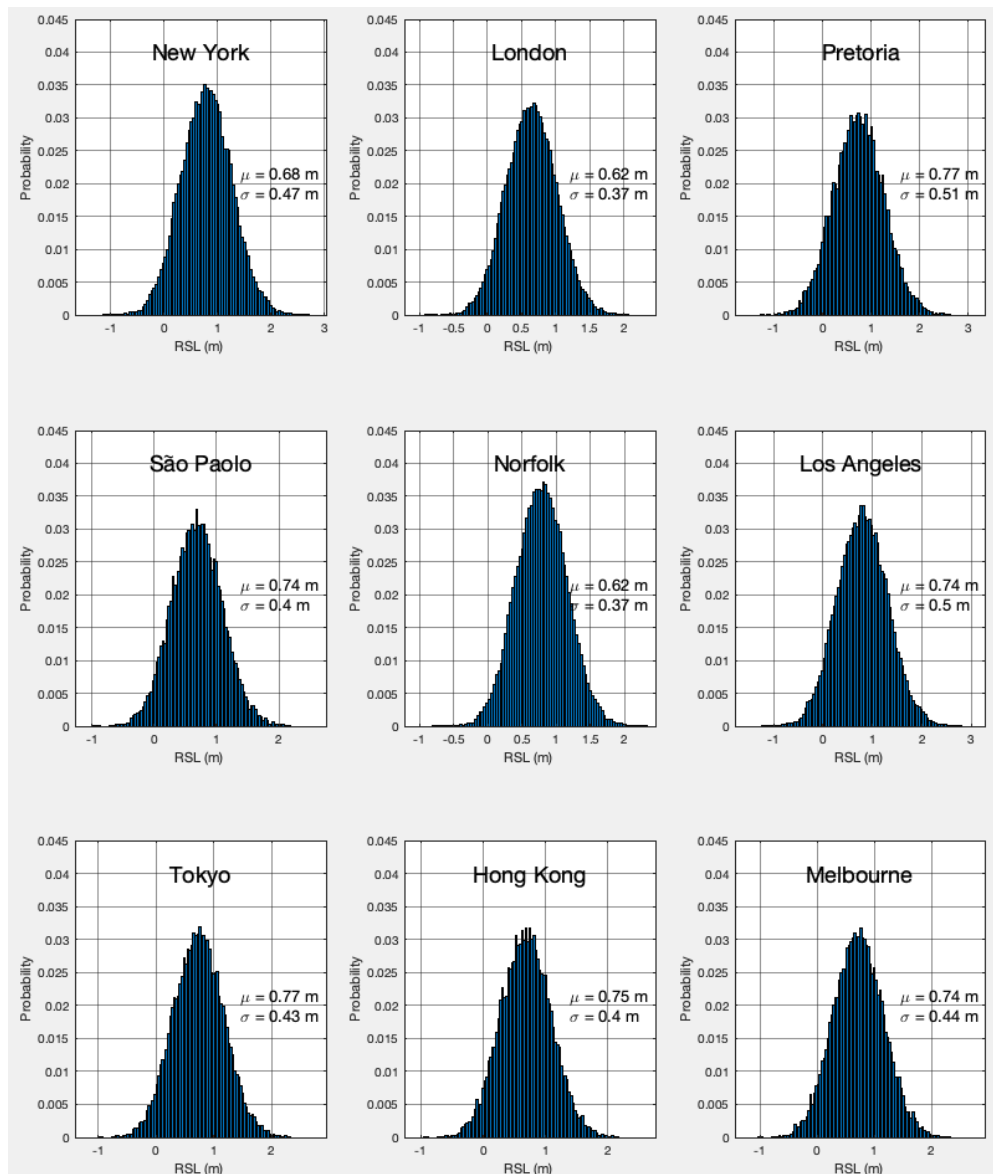
Figure 10. AR5 calibrated projection of RSL for nine cities around the world from 2007 to 2100. Sampling was carried out for H AIS , H GIS , H GLA , STR and H TWS using mean and standard deviations from AR5 (Church et al., 2013a). The patterns for ice thickness are from GRACE 2003–2016 trends (Adhikari and Ivins, 2016). DSL is fully deterministic, from the CMIP5 Norwegian Earth System Model (NorESM)